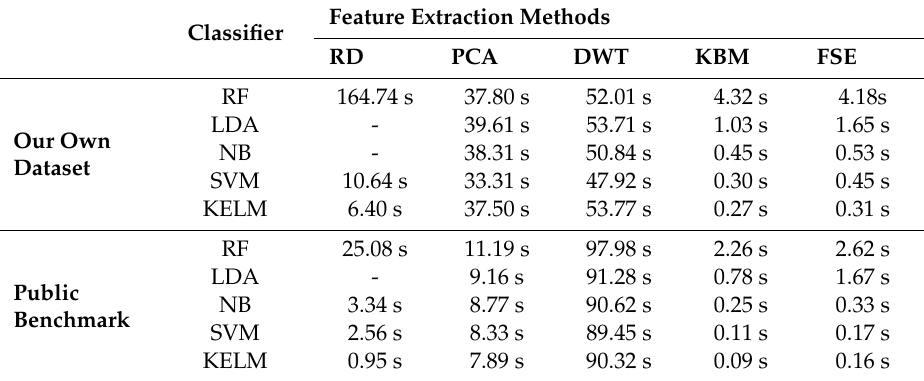
Table 2. Time consumption of models.